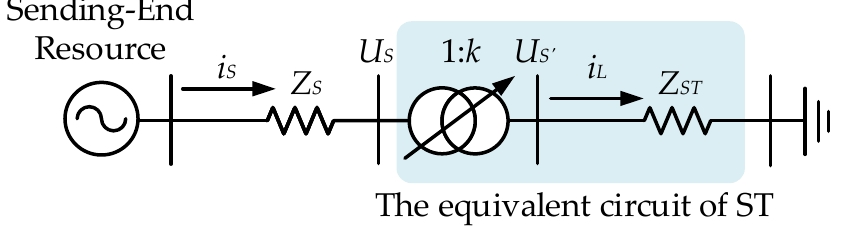
Figure 8. The variation of / k 1 under different phase angles of compensating voltage.